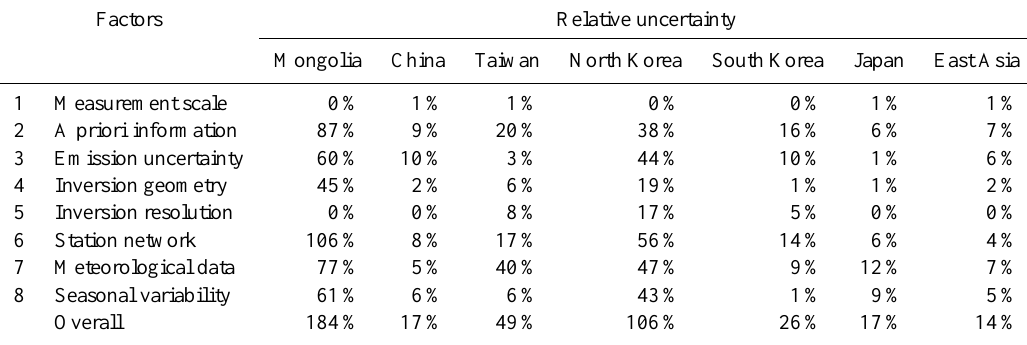
Table 2. Relative uncertainties of a posteriori SF 6 emissions in East Asia as obtained from the different sensitivity tests, as well as total uncertainty assuming that the individual errors are independent.